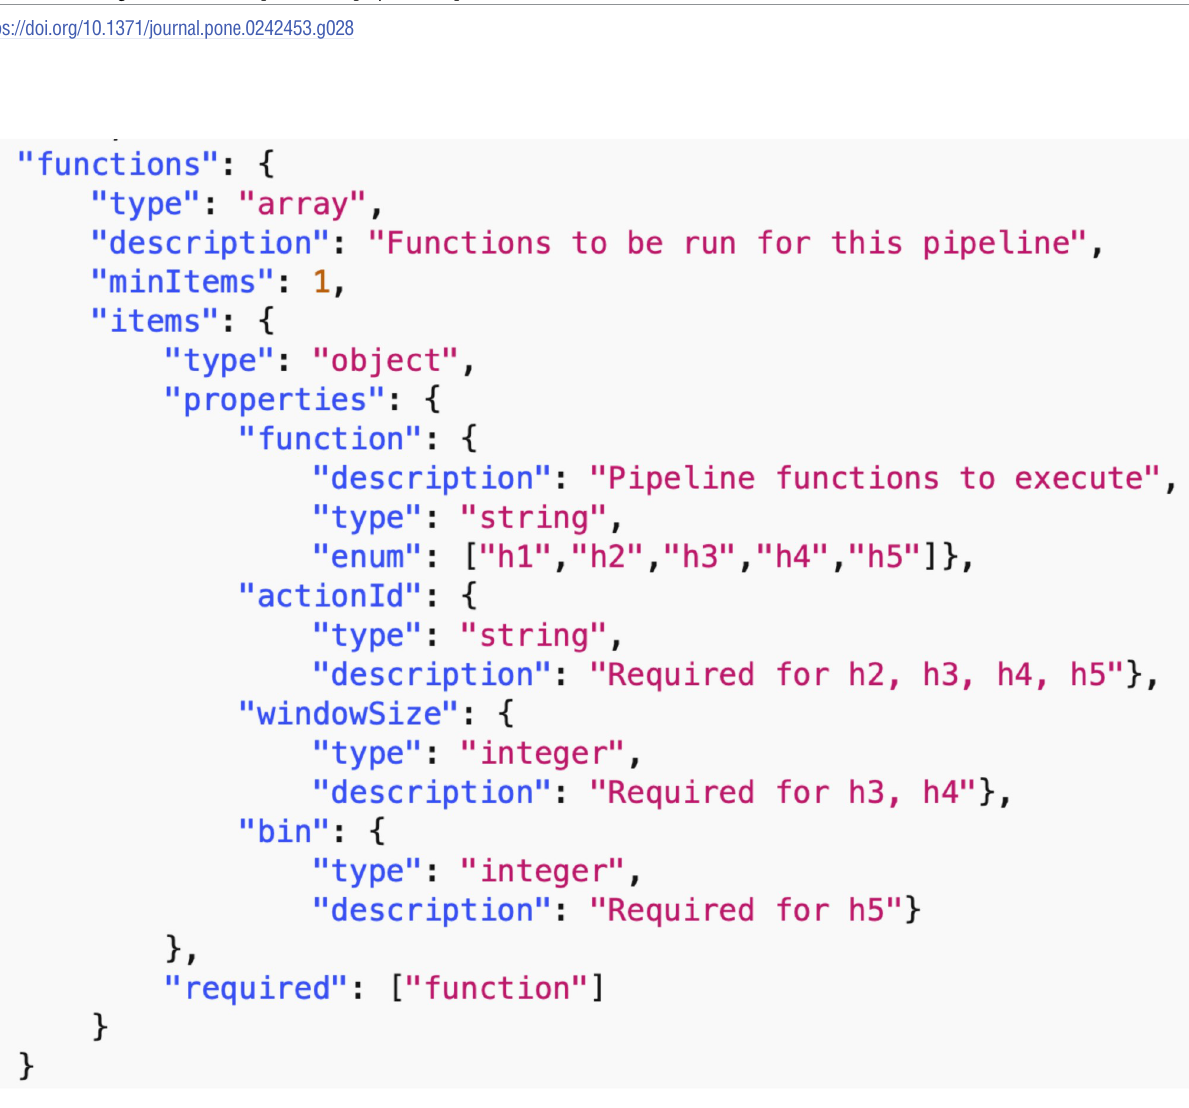
PLOS ONE | https://doi.org/10.1371/journal.pone.0242453 November24,